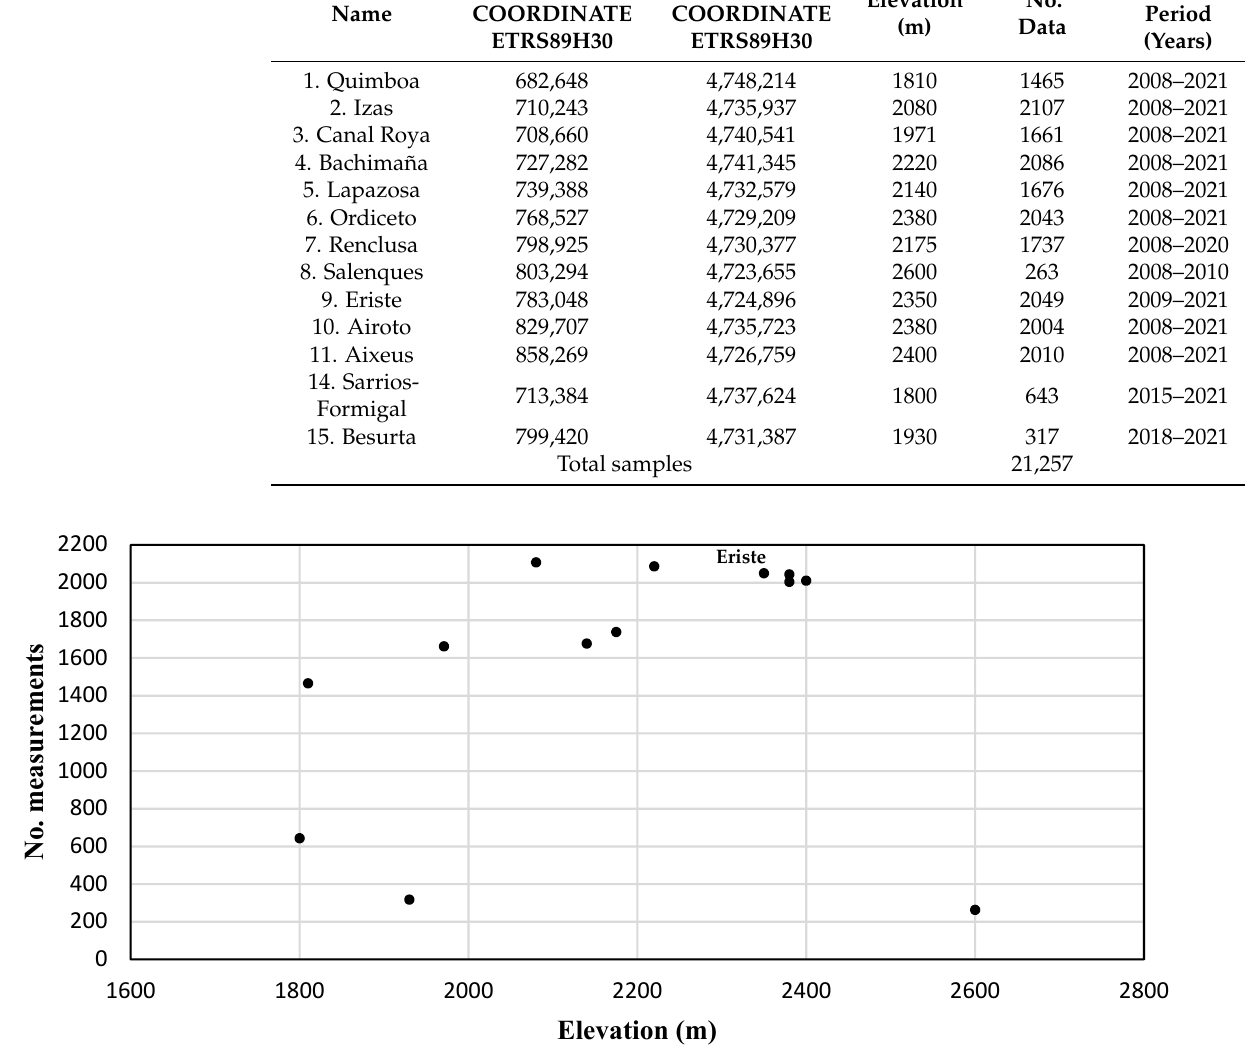
Figure 5. Number of SDEN automatic TNM measurements and elevation distribution.